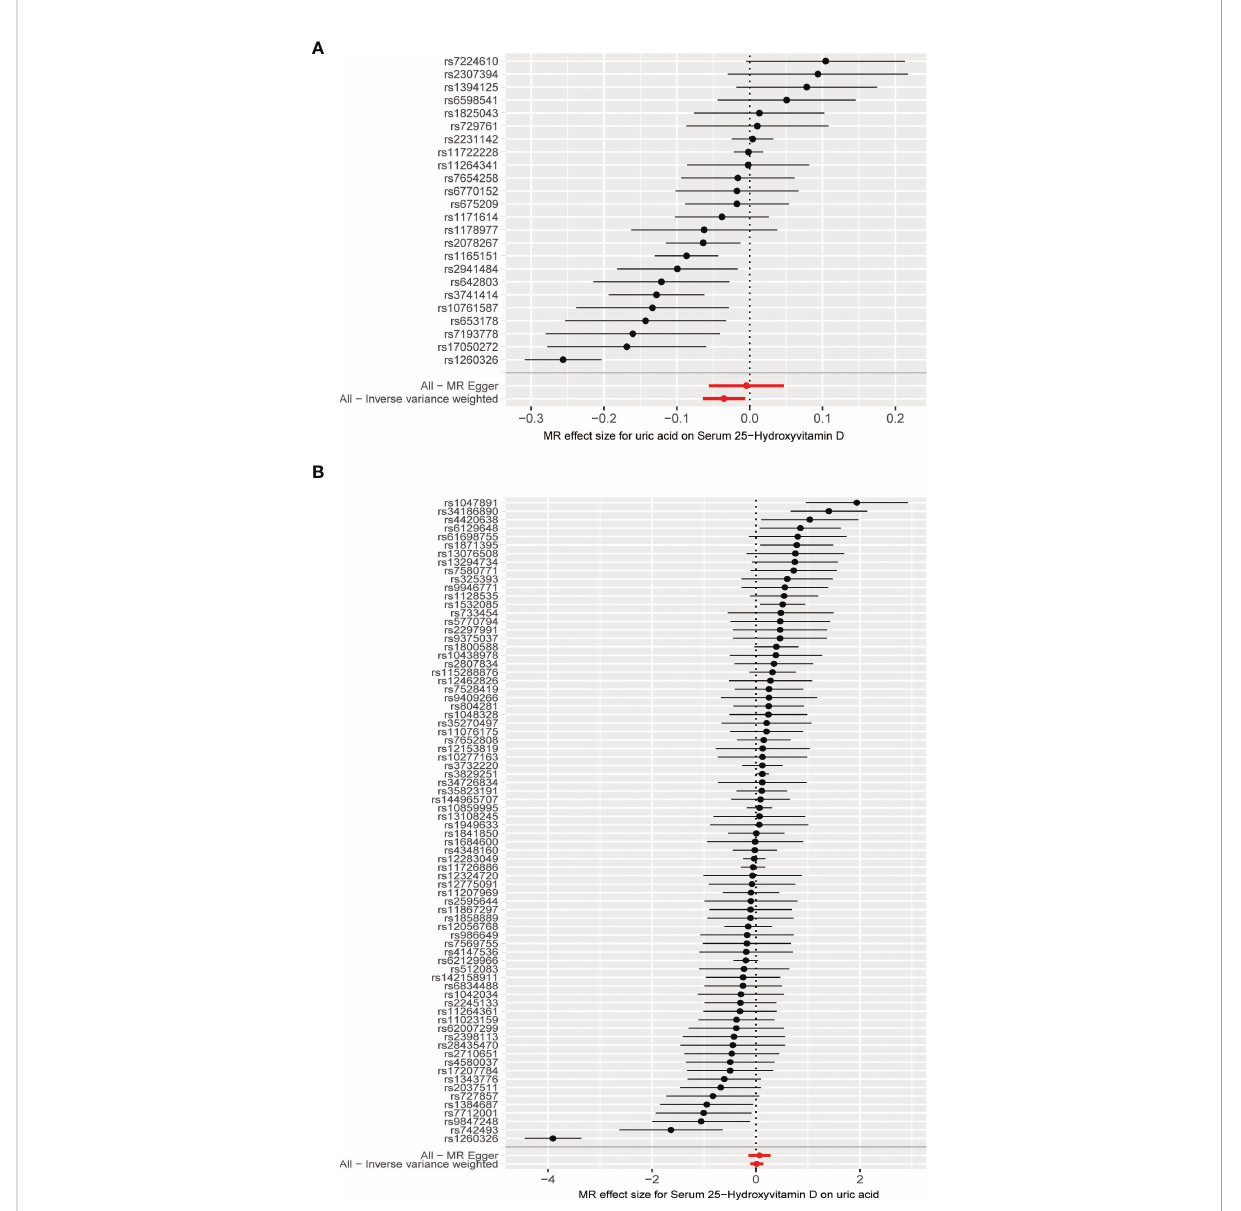
FIGURE 4 (A) Forest plot of causal association for uric acid on 25-hydroxyvitamin D. (B) Forest plot of causal association for 25-hydroxyvitamin D on uric